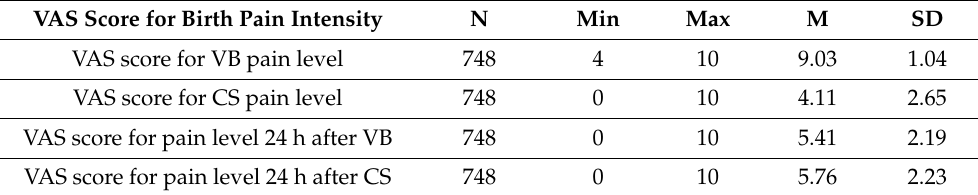
Table 3. Opinions about birth method pain levels (VAS